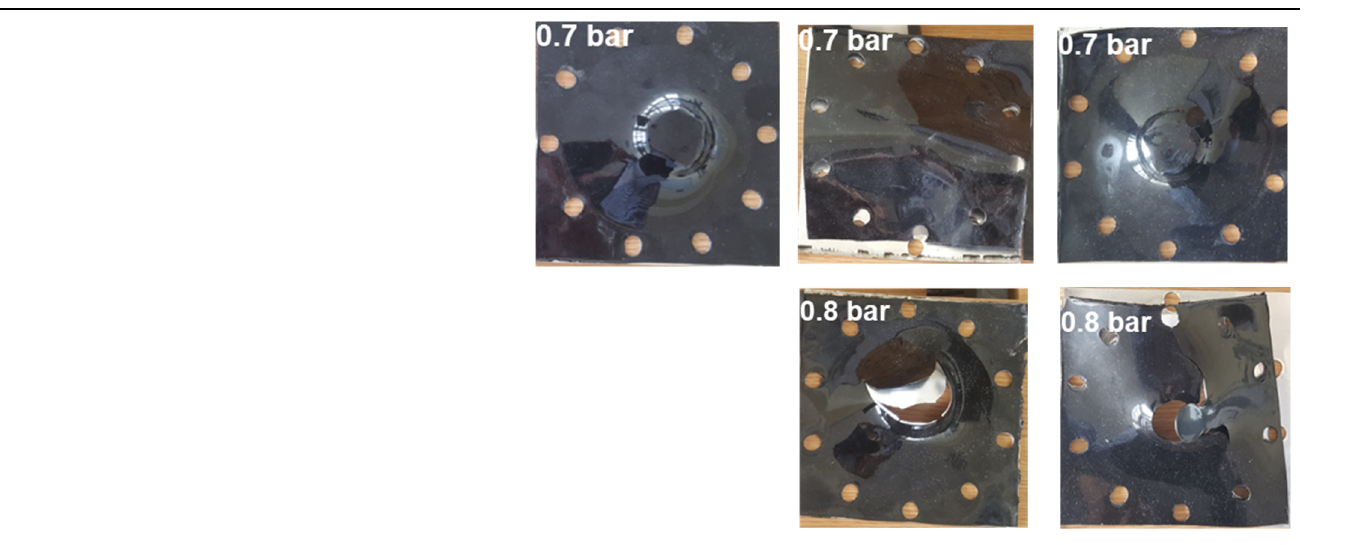
Figure 10. Maximum force values obtained during the impact tests with Hopkinson bar.